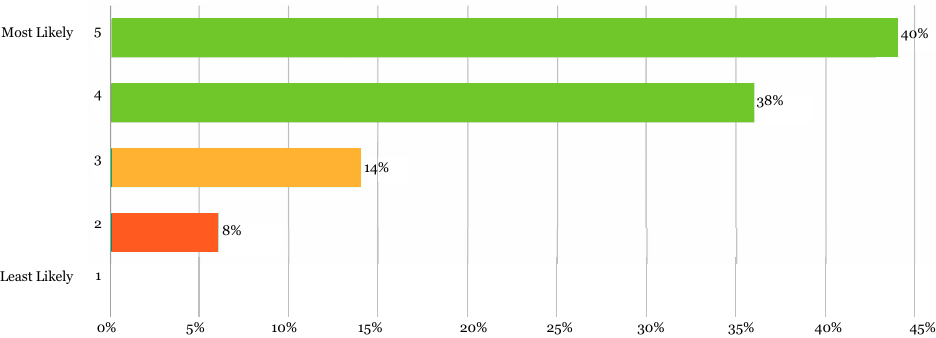
Figure 13. Showing results of exit survey Q6: On a scale of 1–5, how likely are you to use the LPs for sustainable solutions/inspiration in the future? Data were scored as 4–5 = positive (green), 3 = ambivalent (orange), 1–2 = negative (red).